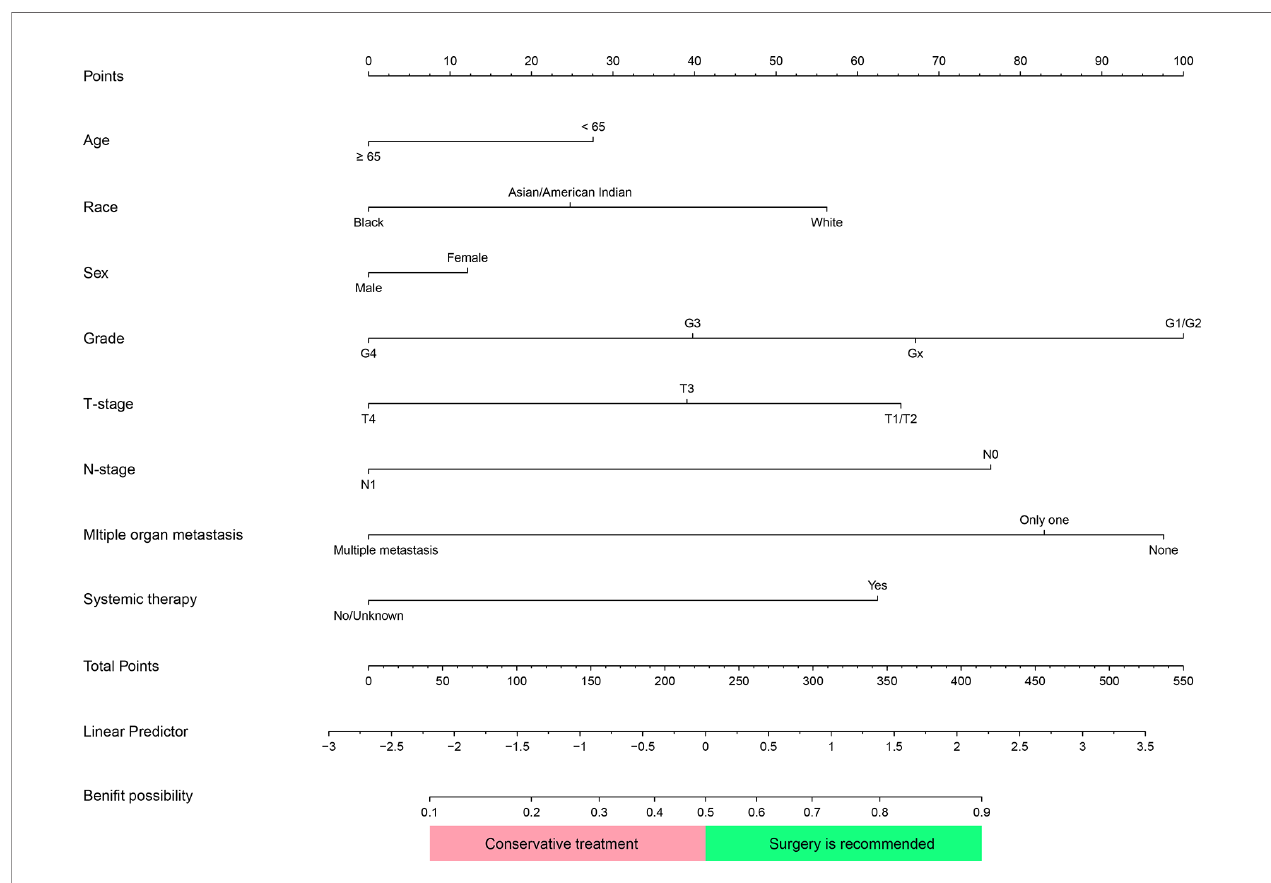
FIGURE 7 | Nomogram was used to identify patients with metastatic clear cell renal cell carcinoma(mccRCC) who would bene fi t from Cytoreductive Nephrectomy. Corresponding scores of each variable were added to get a total score, then calculating the possibility of getting bene fi t. Patients whose Bene fi t possibility>0.5 were recommended for this surgery.